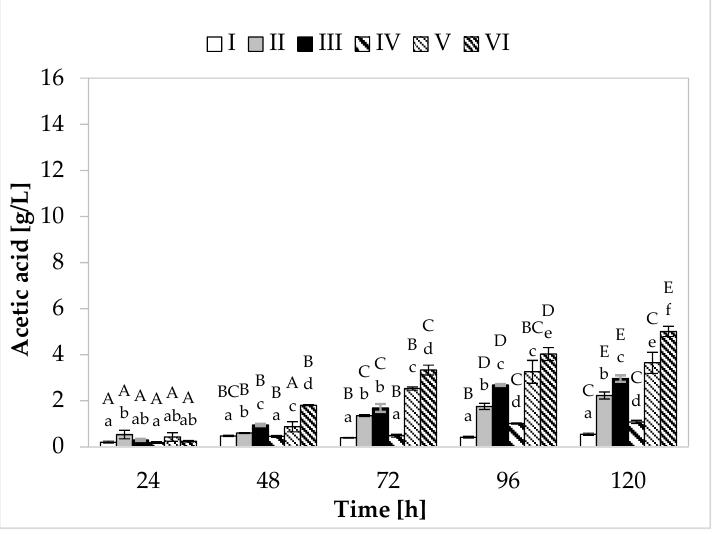
Figure 3. Acetic acid production. A, B, C, D, and E—homogeneous groups of the influence of the cultivation time on the production of acetic acid—the Tukey’s test (a one-way analysis of variance was performed); a, b, c, d, e, and f—homogeneous groups of the influence of the medium on the production of acetic acid—the Tukey’s test (a one-way analysis of variance was performed). Table 2. Parameters of propionic acid fermentation. The highest efficiency of propionic acid production was observed in medium V